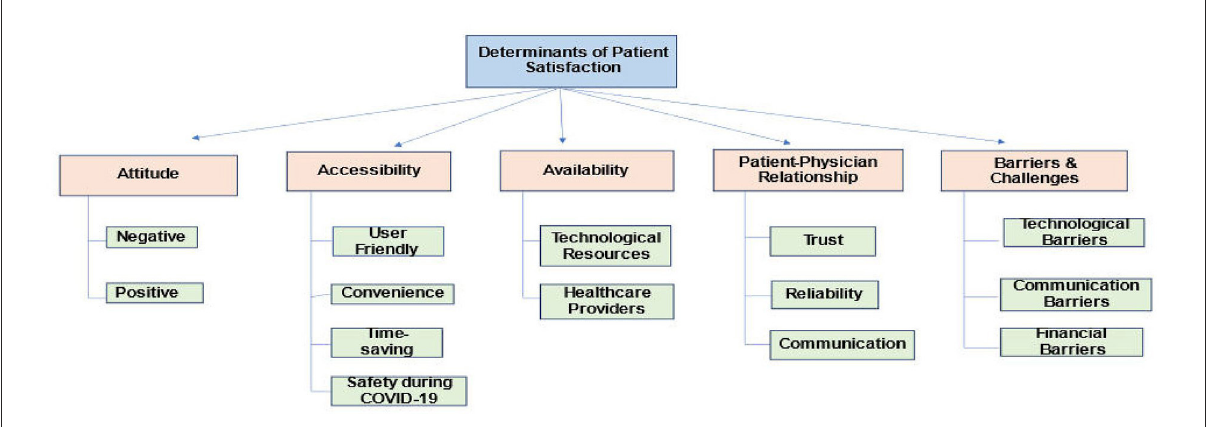
FIGURE6 Determinants of patient